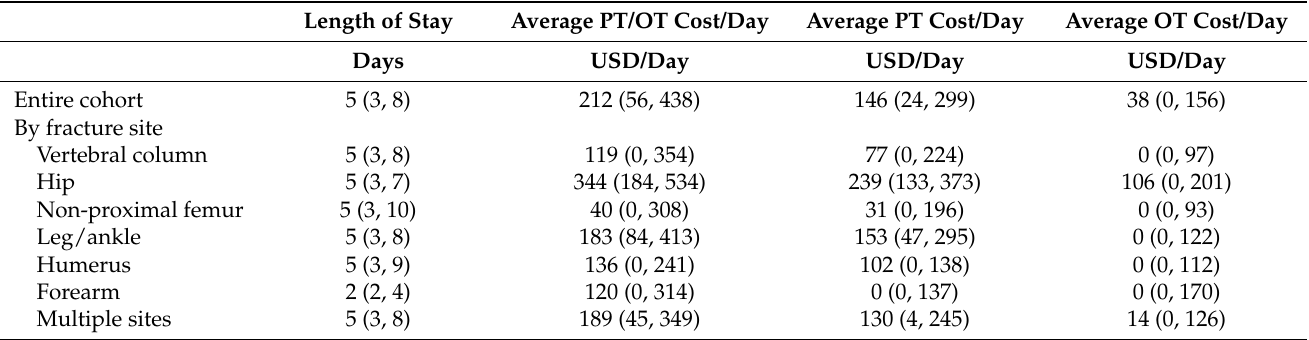
Table 2. Length of stay and average physical therapy (PT) and/or occupational therapy (OT)